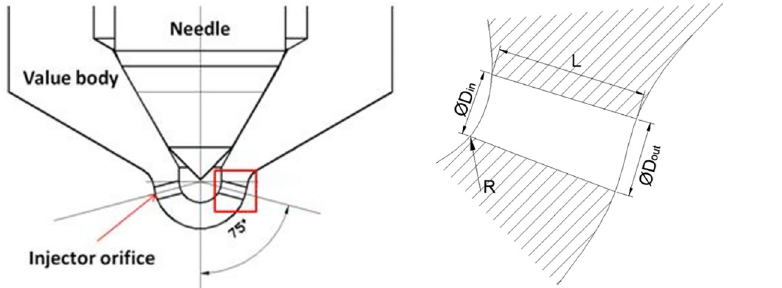
Fig 1. Nozzle geometry parameter schematic diagram.